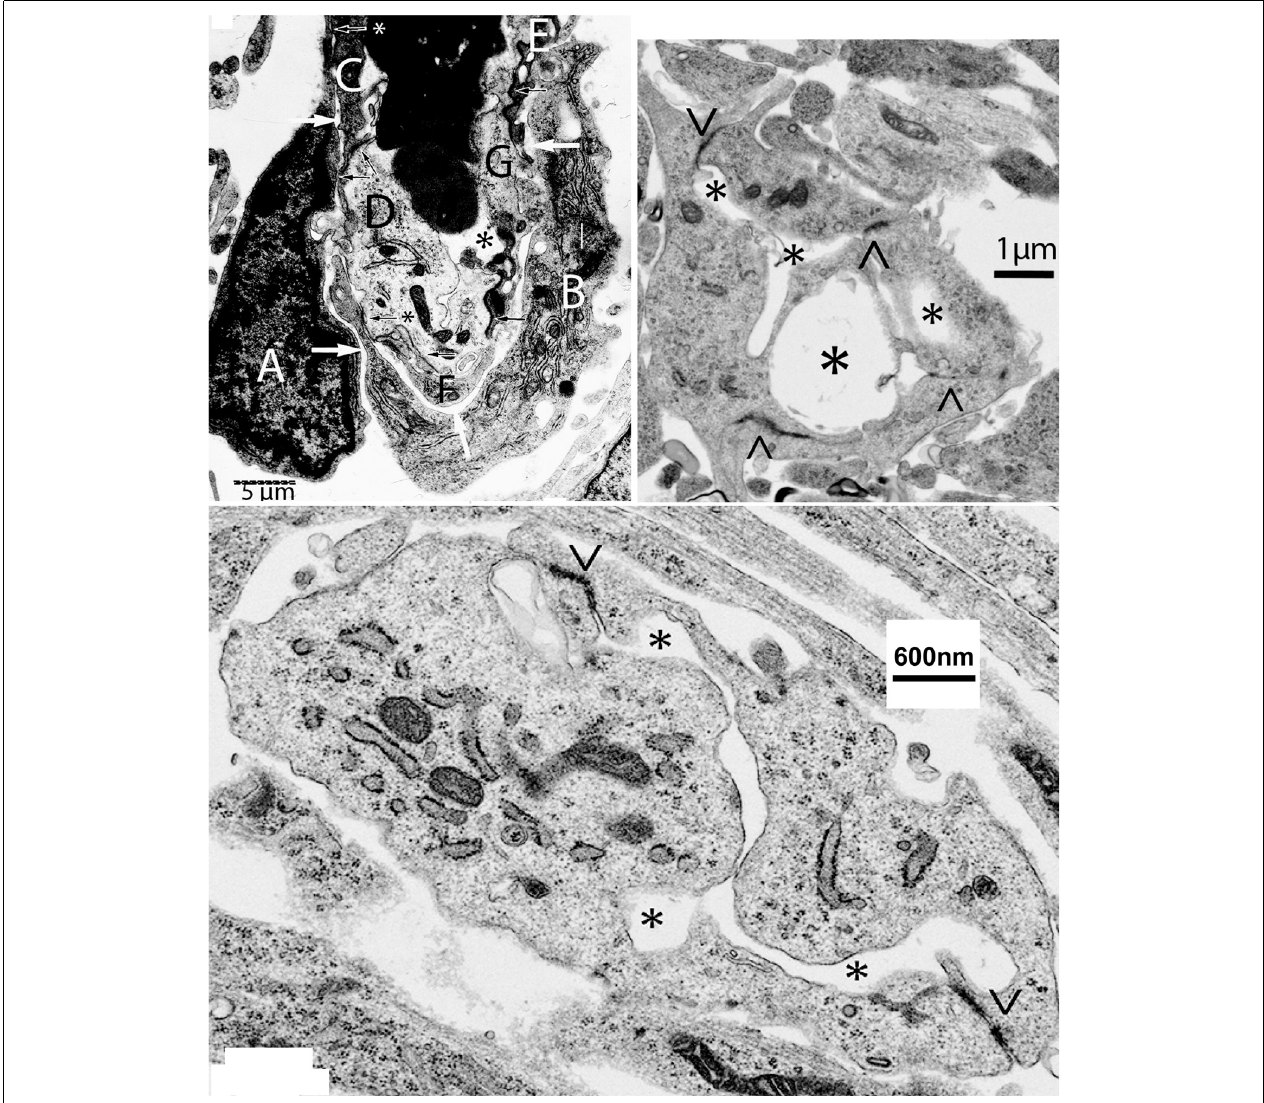
FIGURE 2 | Composite figure of electron microscopy micrographs showing growing capillaries in the mouse cerebral cortex. Top-left , electron microscopic view of the bulging head of a perforating meningeal capillary with nucleated red cells in its lumen (asterisk), showing its endothelial cell (EC) composition and organization. Some of the ECs (C–G) are components of the capillary wall and share tight junctions (black arrows). The two additional ECs (A,B) are separated by a thin intercellular space from those of the capillary wall by a long space (white arrows) and share small tight junctions with those of the capillary wall (arrows with asterisks). The presence of two additional ECs (A,B) explains the bulging of the polypoid head of growing capillaries (see Figure 1 ). The additional ECs (A,B) are the only ones with searching filopodia. Top-right , electron microscopic view of a new post-anastomotic central nervous system (CNS) capillary composed of three ECs separated by tight junction ( < , > ) and with three irregular lumina (asterisks), reflecting a multiple luminal origin. Bottom , view of recently formed post-anastomotic CNS capillary composed of two ECs separated by tight junctions ( < , > ) with a small narrow and convoluted single lumen (asterisks). The post-anastomotic new CNS capillaries